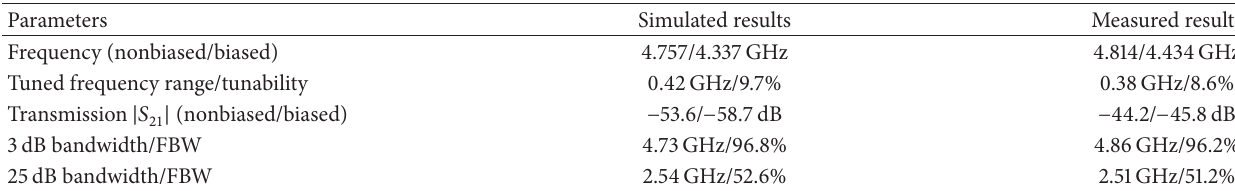
Table 2: Comparison between the simulation and measurement results of the proposed BSF.